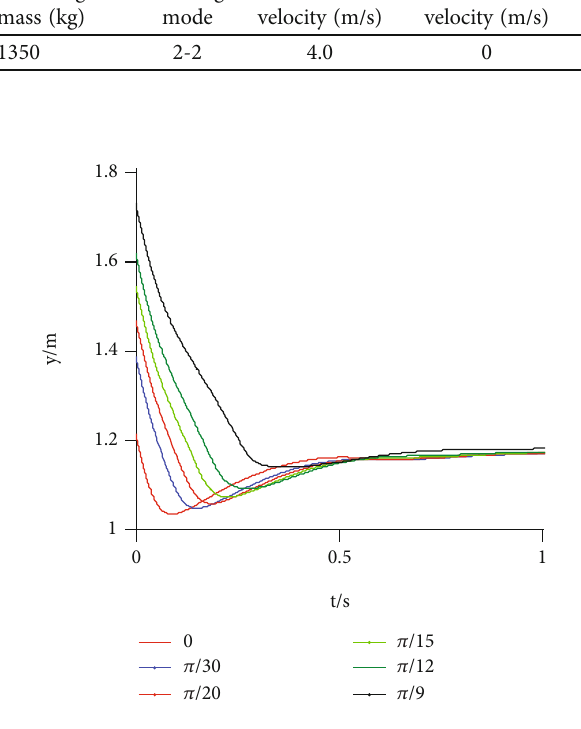
Figure 10: Body displacement vs. time.